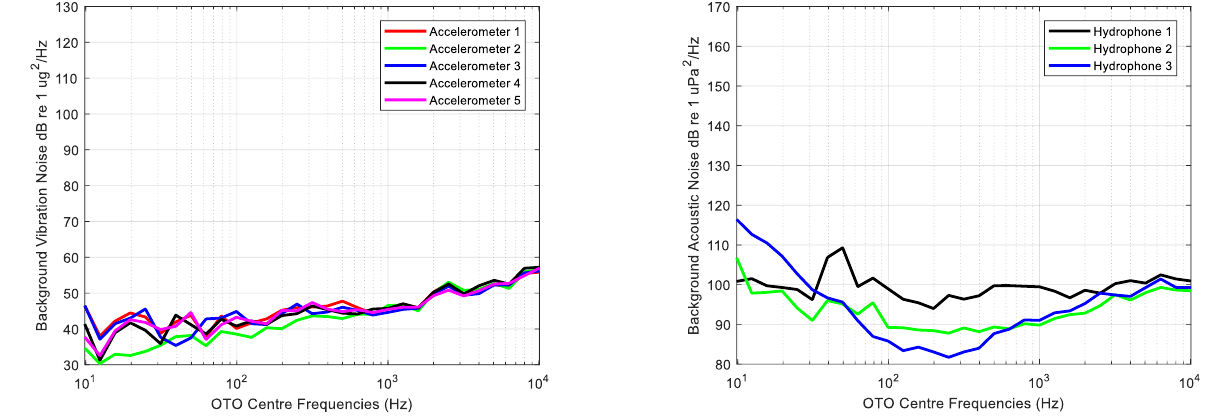
Figure 7. Average of each one third octave processed for all background measurements for each accelerometer ( left ) and each hydrophone ( right ).